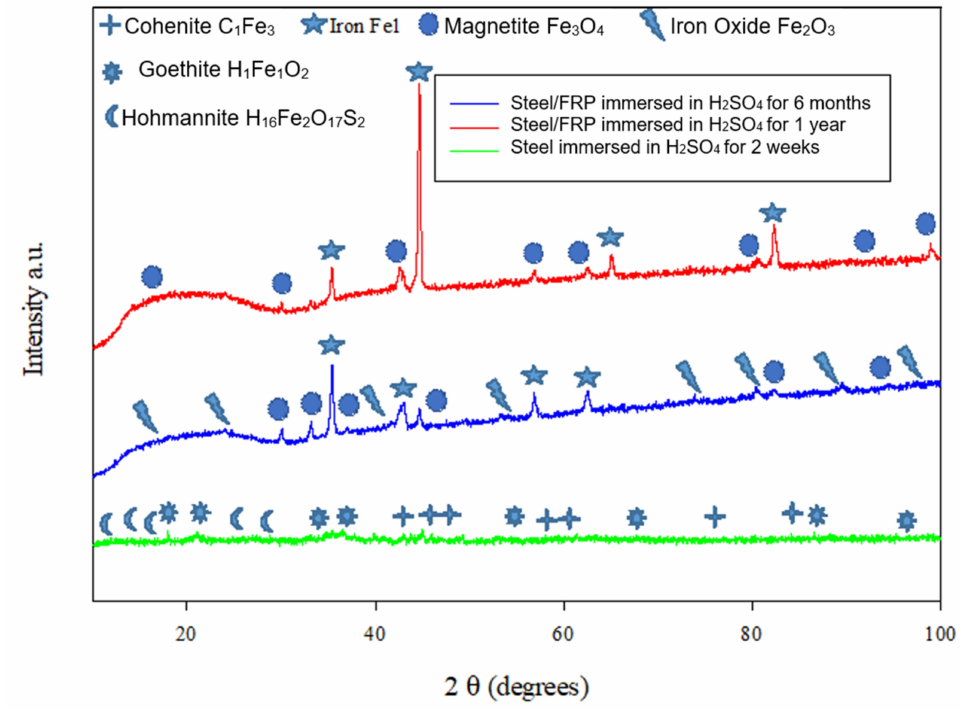
Figure 6. XRD patterns for the steel surfaces after immersion in H 2 SO 4